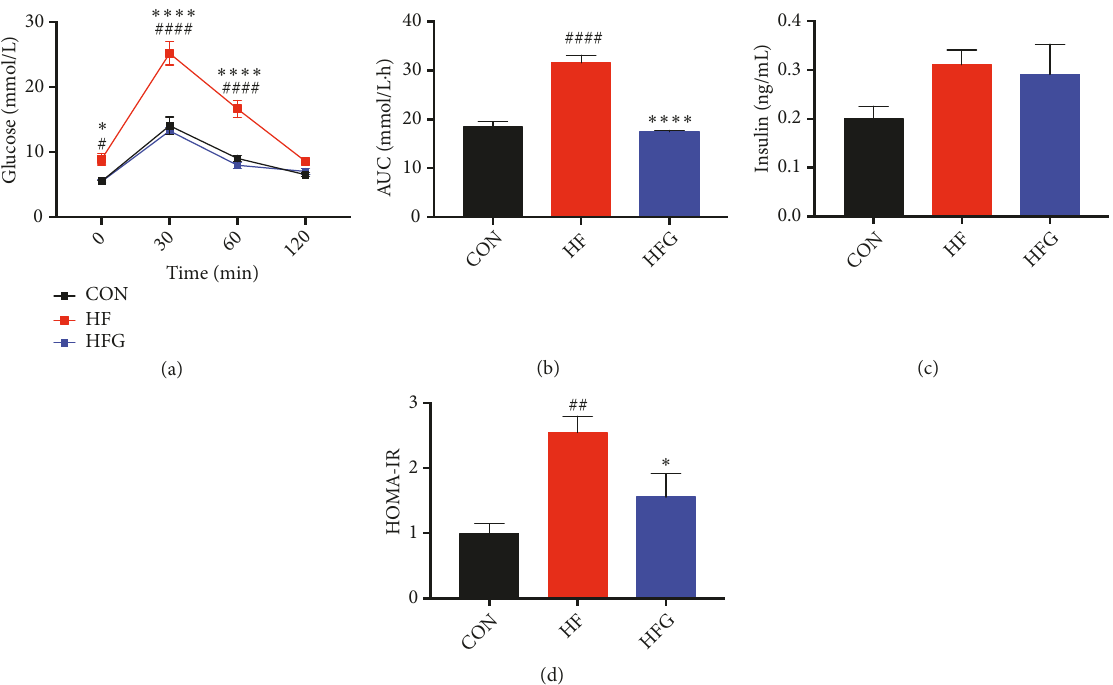
Figure 2: Genisteinimproved the glucosetoleranceand insulin sensitivity in mice fed HFG diet compared with those fed HF diet. (a) IPGTT; (b) AUC; (c) serum insulin levels; (d) HOMA-IR. IPGTT: intraperitoneal glucose tolerance test; AUC: area under the curve; HOMA-IR: the homeostasis model assessment of insulin resistance. CON: normal control diet; HF: high-fat diet without genistein; HFG: high-fat diet with genistein. Data are expressed as means ± S.E.M. (n=8/group). Mean values were significantly different between other groups and the CON group: # p < 0.05; ## p < 0.01; ### p < 0.001; #### p < 0.0001. Mean values were significantly different between HF group and the HFG group: ∗ p < 0.05,